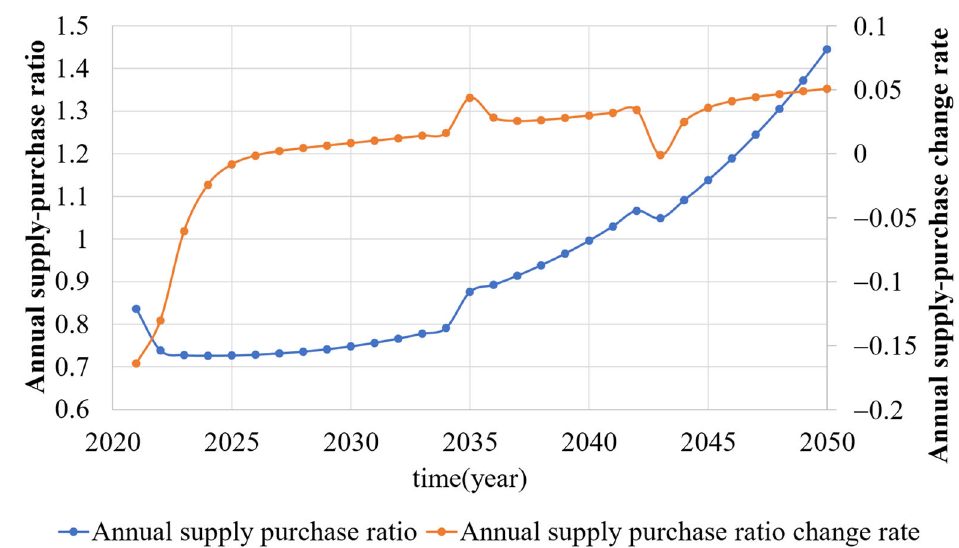
Figure 3. Simulation results of annual supply–purchase ratio and annual supply–purchase ratio change rate under the base scenario.